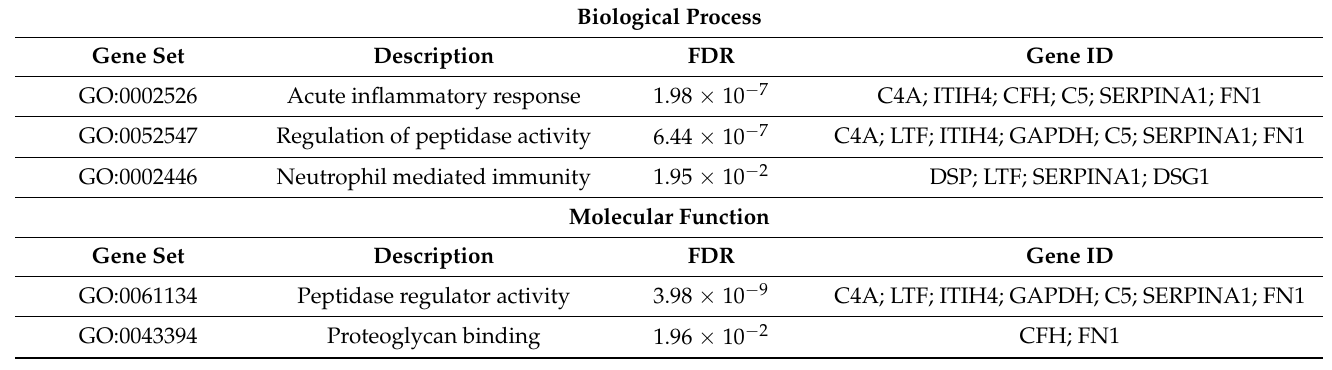
Table 4. Gene Ontology analyses of the differentially expressed proteins after 6-month treatment with denosumab.